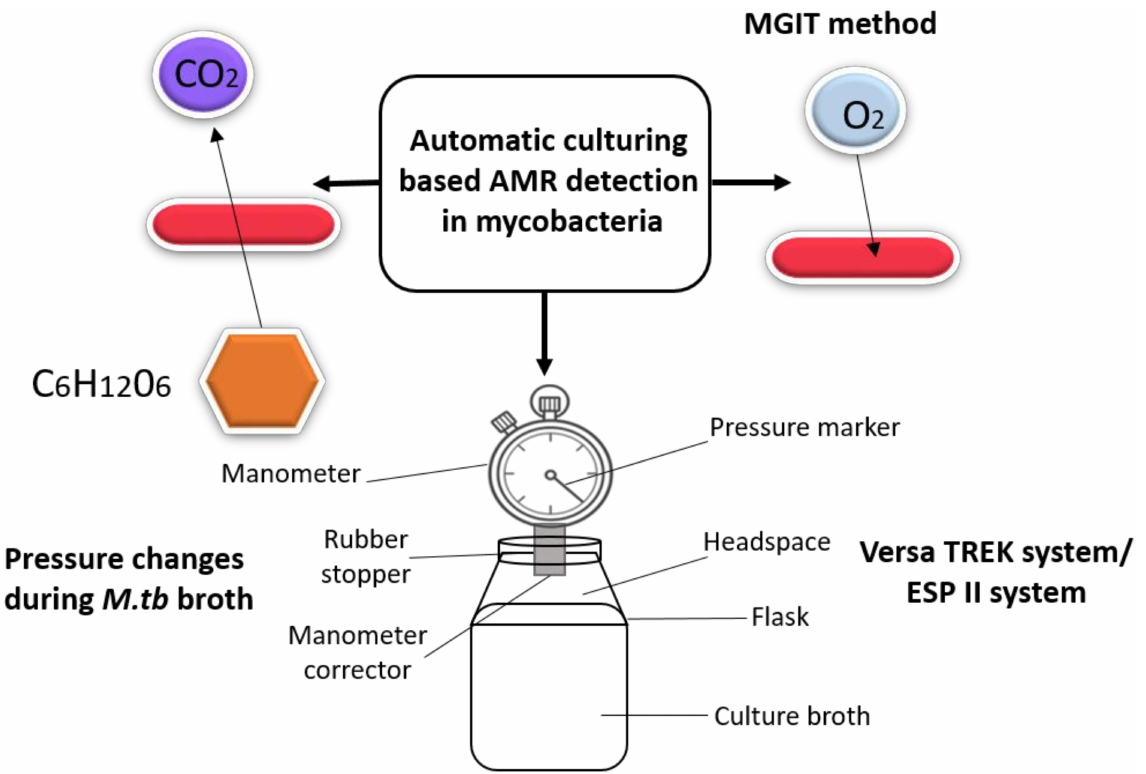
Figure 3. Recent advancements in automated culturing methods for drug resistance detection in Mtb